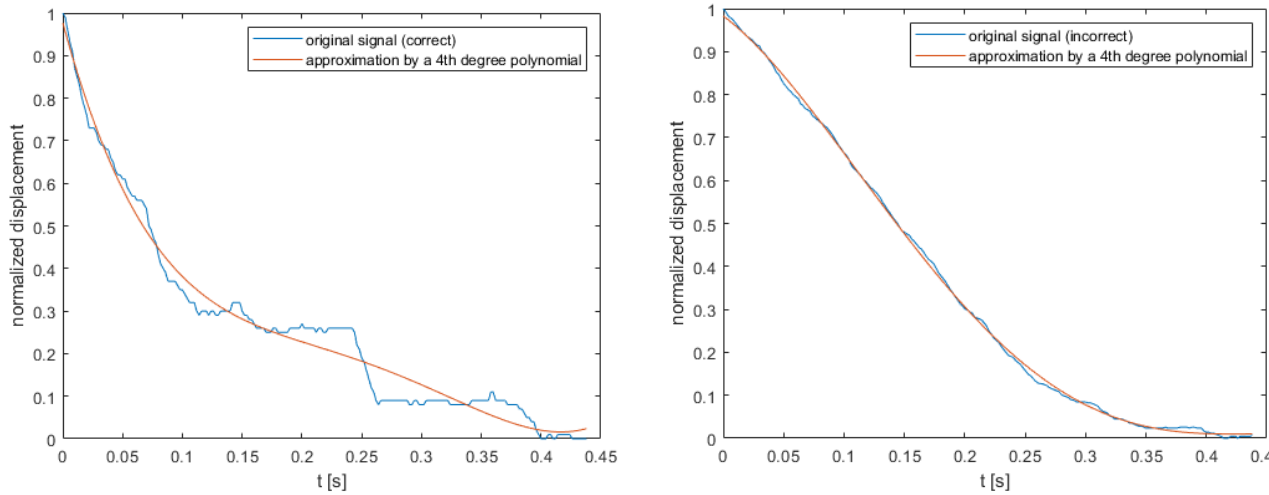
Figure 9. Original correct (on the left ) and incorrect (on the right ) signal of displacement and approximation by 4th degree polynomial.